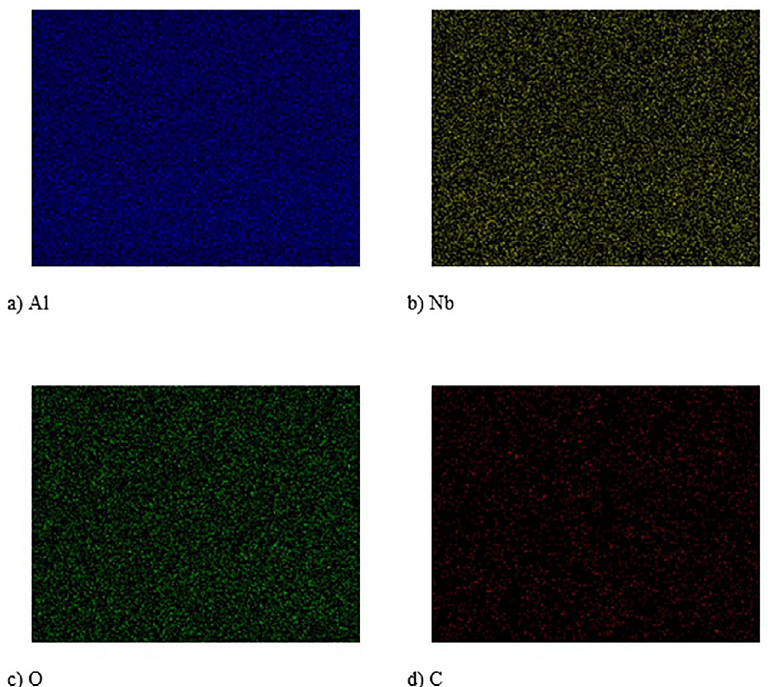
Figure 6. Polarization curves for AISI steel 1020, 3.5% NaCl, at room temperature, coated with mixed oxide precursor sol of Nb